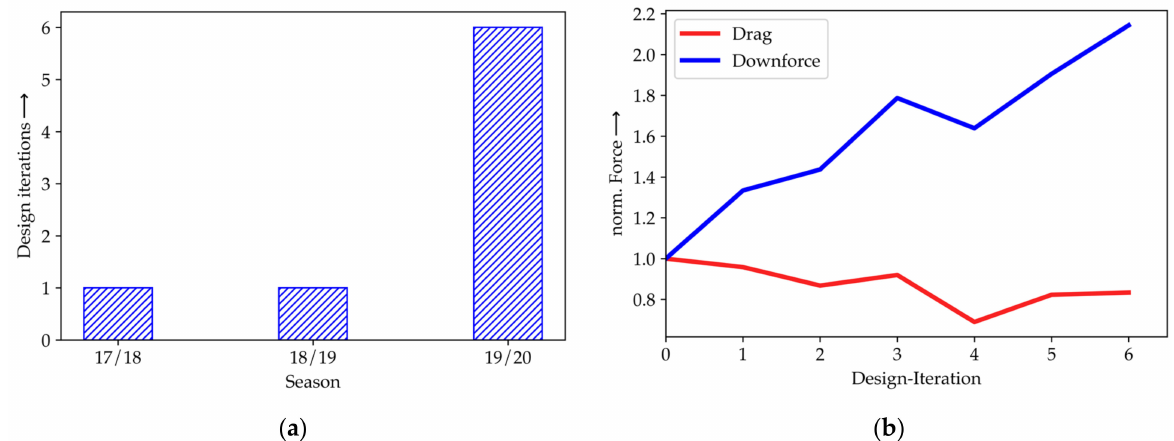
Figure 5. Increment in simulations and progress within one year. ( a ) Number of conducted design iterations per season. ( b ) Progress achieved during the season 19/20 by the means of reduction in drag and the increase in downforce. Design iteration 0 represents the status quo at the beginning of the